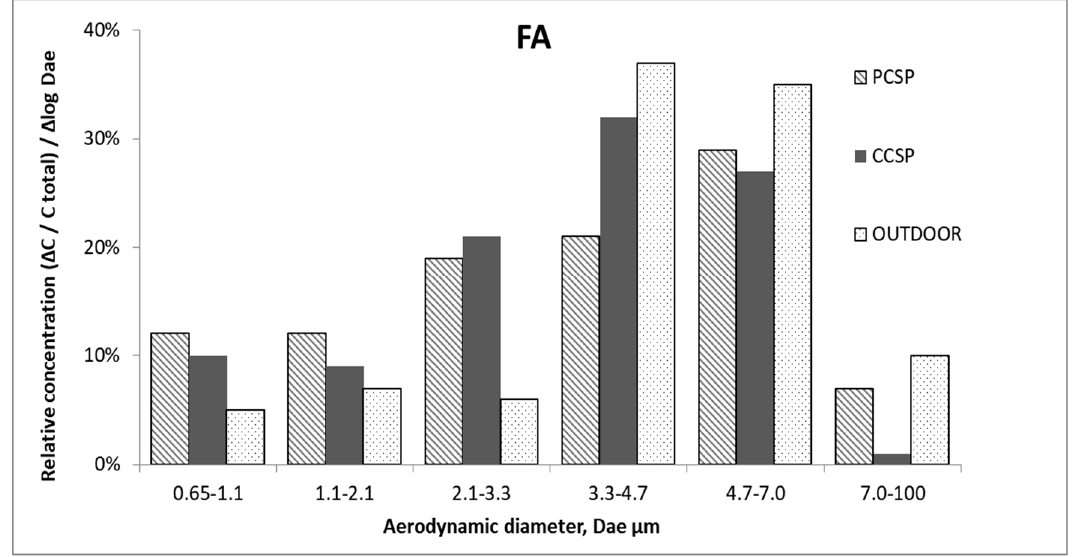
Figure 4. The size distribution of FA in the PCSP, CCSP and outdoor air.